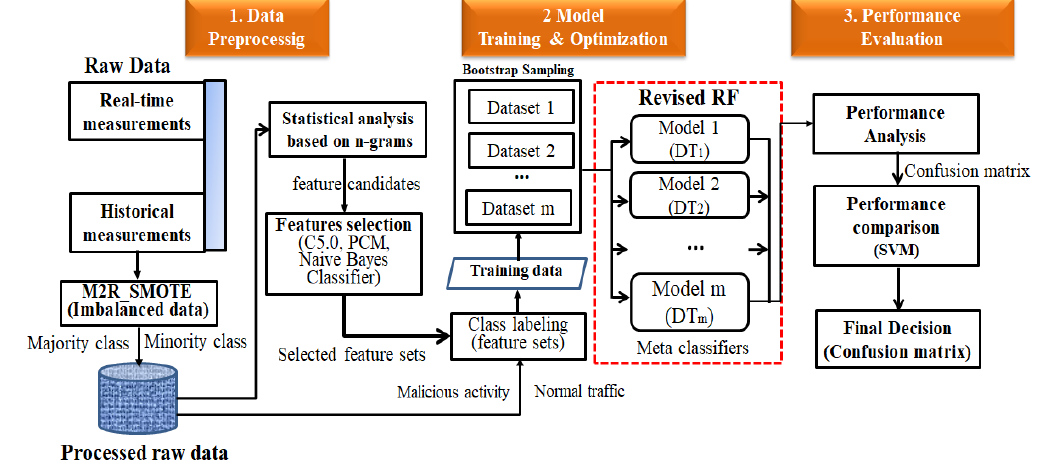
Figure 5. Diagram of developed NID model.